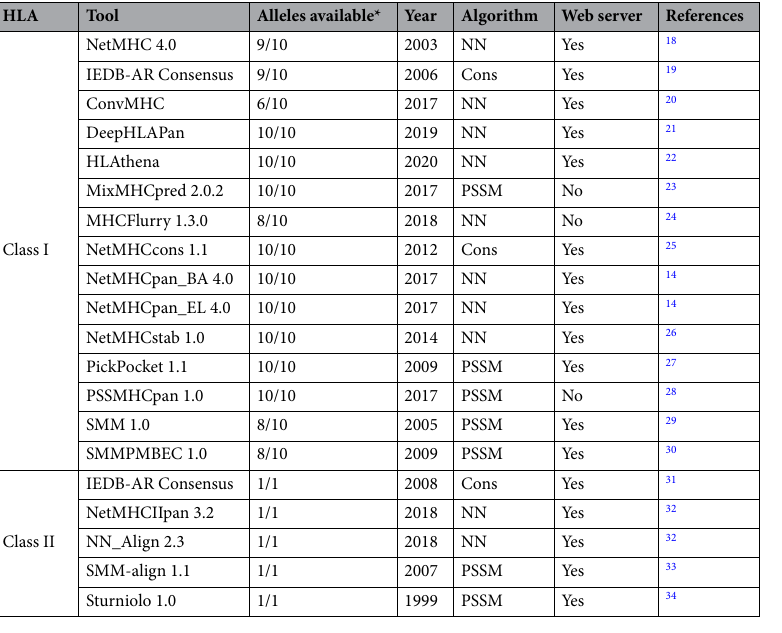
Table 1. Current best-performing or novel HLA prediction tools 10 . Webservers checked on 2 March 2020, NN: Neural network, Cons: Consensus, PSSM: Position specific scoring matrix. *Availability as a fraction of alleles included in study (10 HLA class I and 1 of HLA class